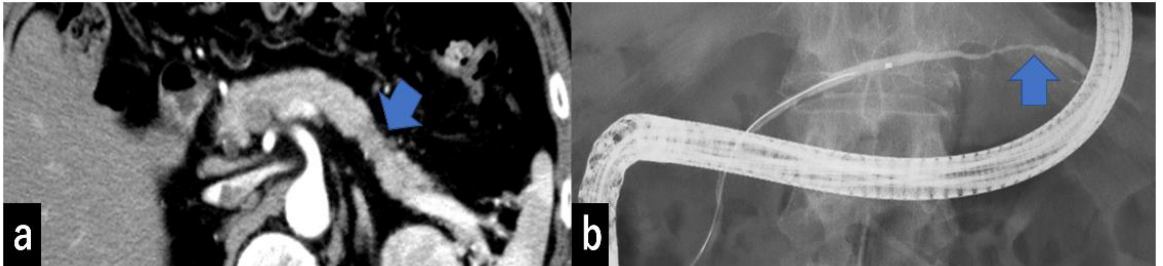
Figure 4. ( a ) CECT shows focal pancreatic atrophy in the pancreatic tail (arrow). ( b ) ERCP shows narrowing of the MPD at the pancreatic tail (arrow) but no MPD dilatation of more than 3 mm. CECT, contrast-enhanced computed tomography; ERCP, endoscopic retrograde cholangiopancreatography; MPD, main pancreatic duct. Type II: Cases that form a mass located in the pancreatic uncus region (Figure